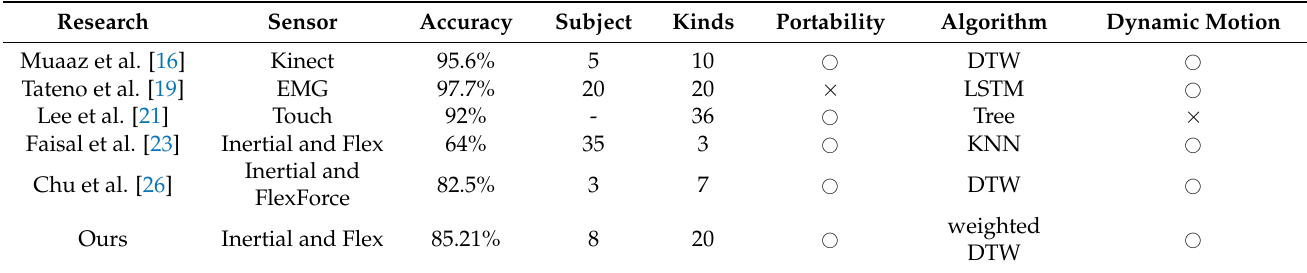
Table 1. Comparison of related research (KNN: K-nearest